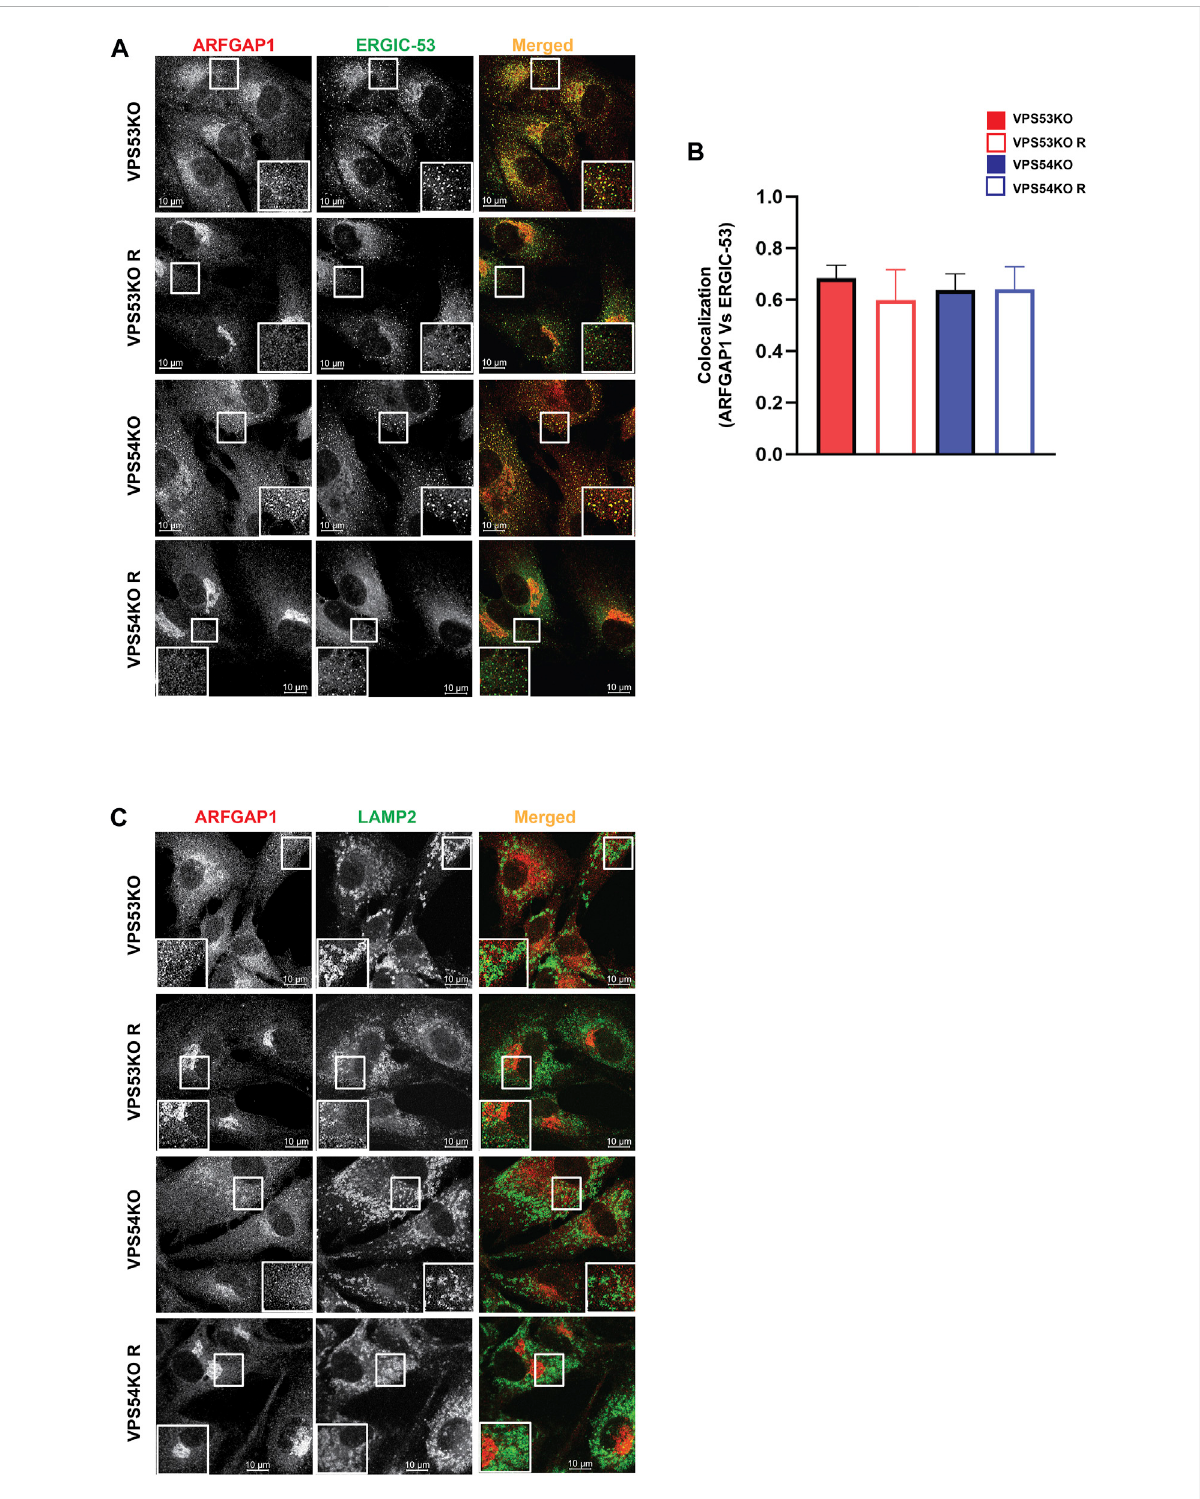
FIGURE 8 GARP depletion does not affect ARFGAP1 localization to ERGIC. (A) Airyscan microscopy of GARP-KO and control cells co-stained for ARFGAP1 and ERGIC-53. The large white square box inside the image is the zoomed view of the small square box (2X inset). (B) Colocalization analysis of ARFGAP1 and ERGIC-53 using Pearson ’ s correlation coef fi cient. (C) Airyscan microscopy of GARP-KO and control cells stained for ARFGAP1 and LAMP2. The large white square box inside the image is the zoomed view of the small square box (2X